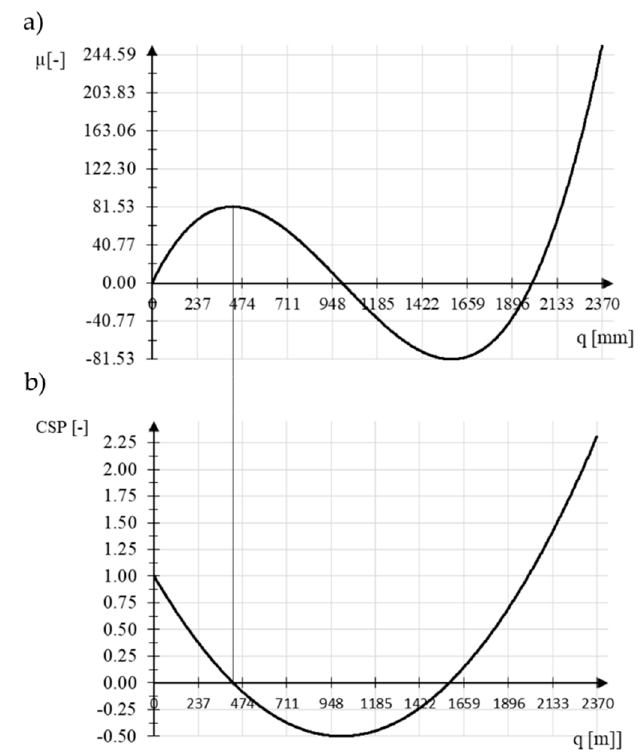
Figure 7. ( a ) Equilibrium path of high von Mises truss, ( b ) CSP-q path of high von Mises truss.